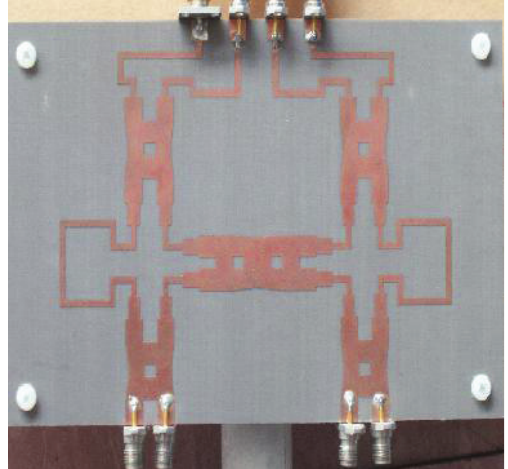
Figure 9: Measurement result for nonuniform crossover.